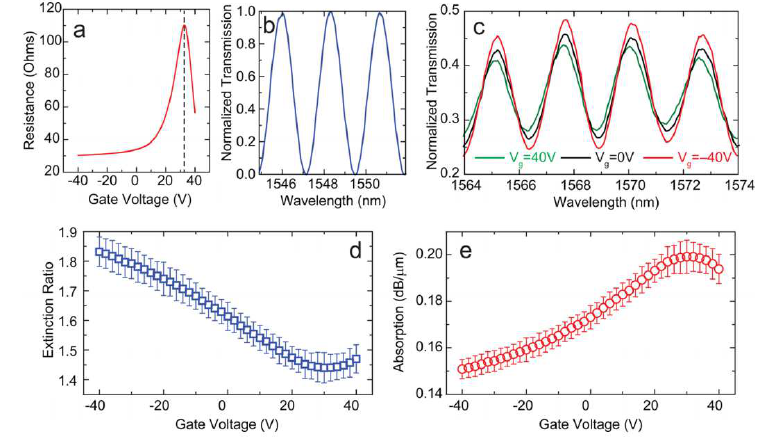
Figure 16. Optical properties based on gate ( a ) resistance of source drain of a graphene and applied gate voltage performance; ( b ) the characteristics based on normalized transmission and wavelength; ( c ) measurement of interference after applied different gate voltage; ( d ) obtaining the excitation ratio in different gate voltage; ( e ) analyzing the absorption coefficient. Reprinted with permission from [141]. Copyright (2012) American Chemical